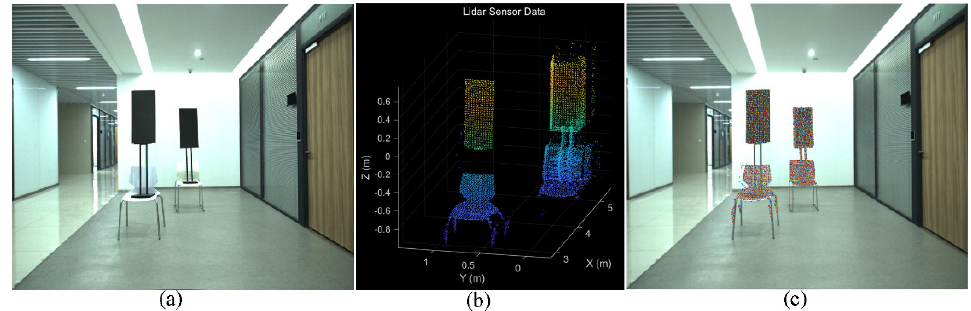
Figure 9. The object is detected by the camera and the LiDAR simultaneously: ( a ) the color image; ( b ) the LiDAR points cloud of the foam boards and chairs; ( c ) the LiDAR point cloud is projected on the color image.